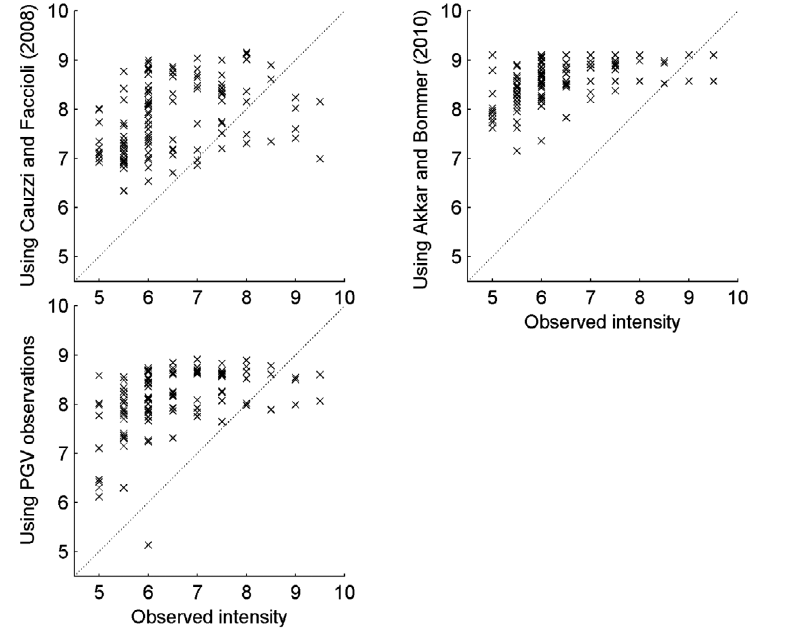
Figure 4. Comparison between observed intensities and those predicted by the three different approaches shown in Figure 2 and Figure 3